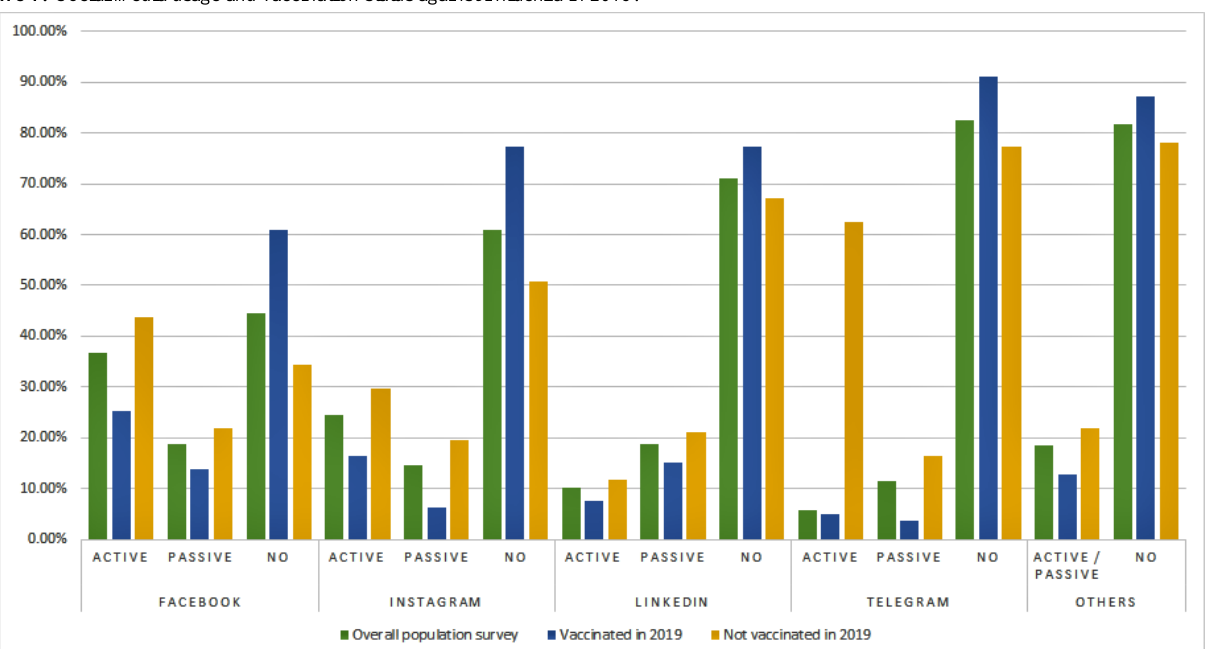
Figure 1. Social media usage and vaccination status against influenza in 2019.